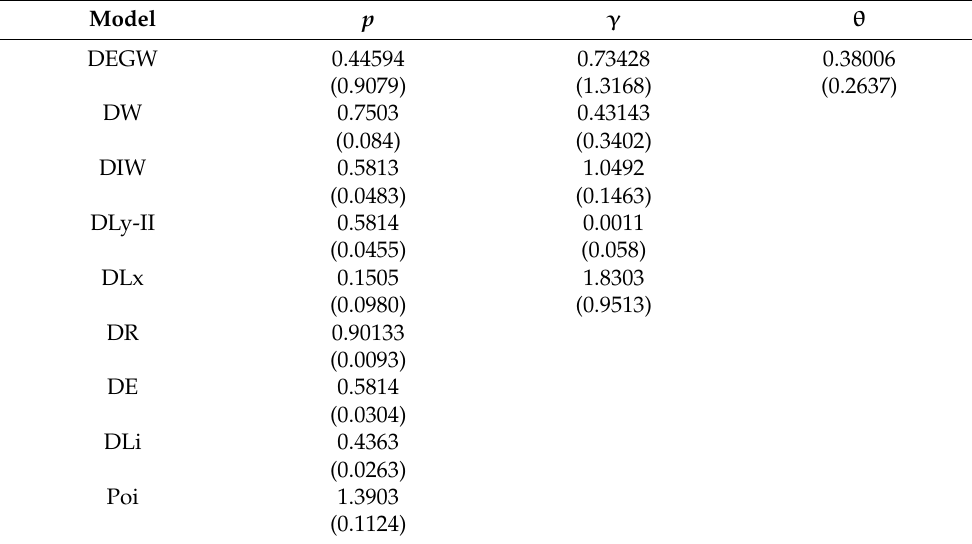
Table 17. The MLEs (and their corresponding St.Ers) for dataset III.